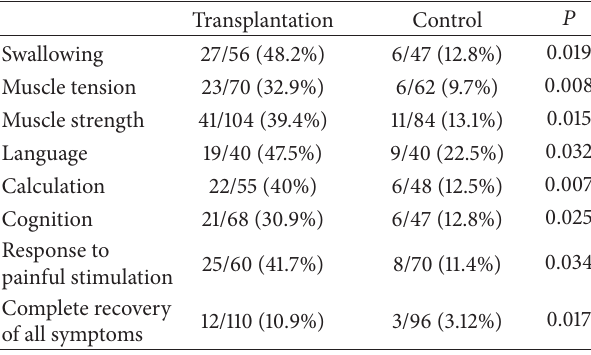
Table 4: Complete recovery of neurological functions 6 months after surgery in patients who had significant impairment after intracerebral